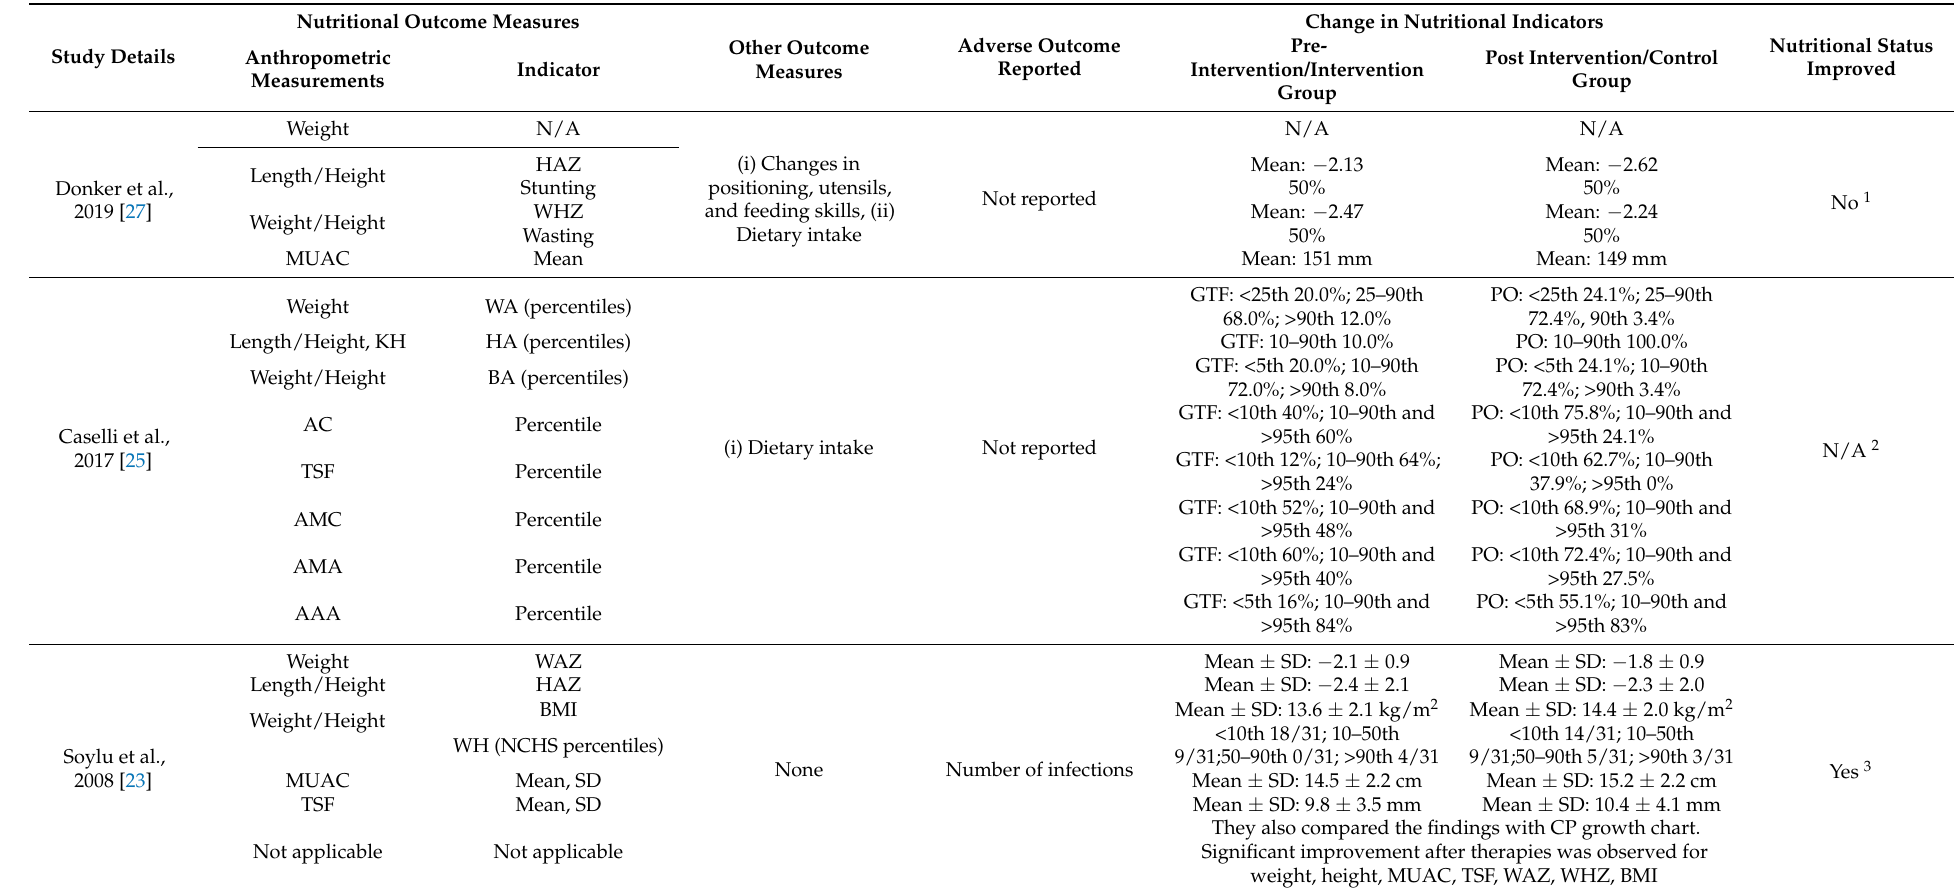
Table 3. The outcome of different interventions provided in the included